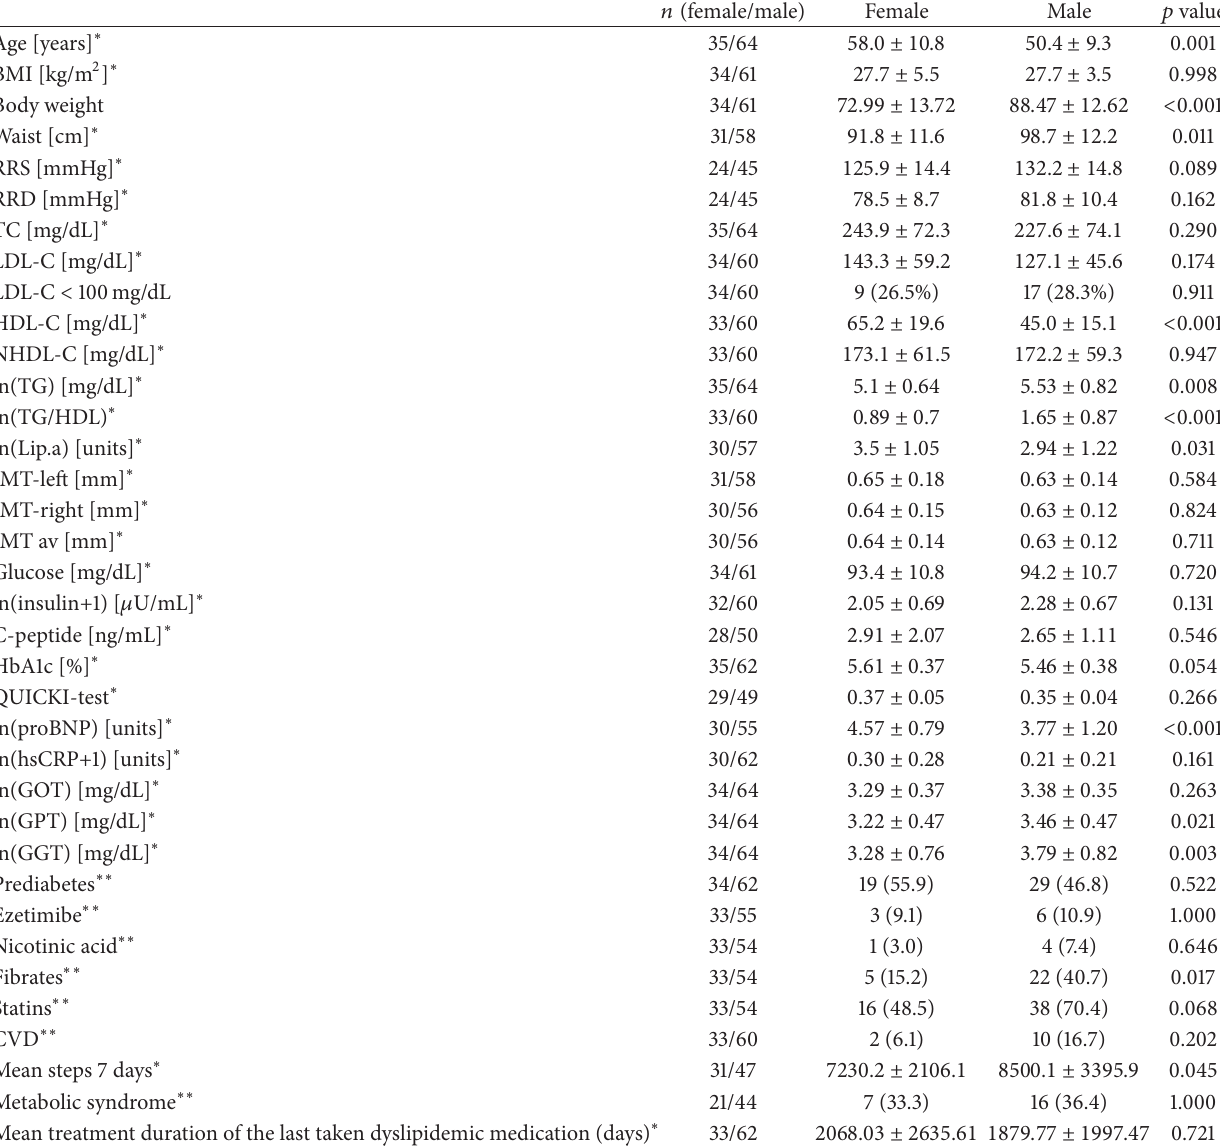
Table 1: Characteristics of the study sample, divided by